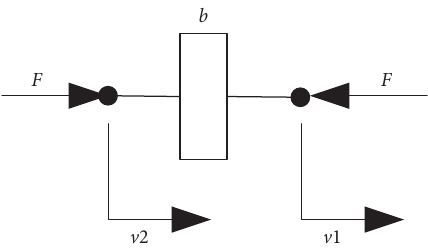
Figure 1: Symbolic representation of inerter